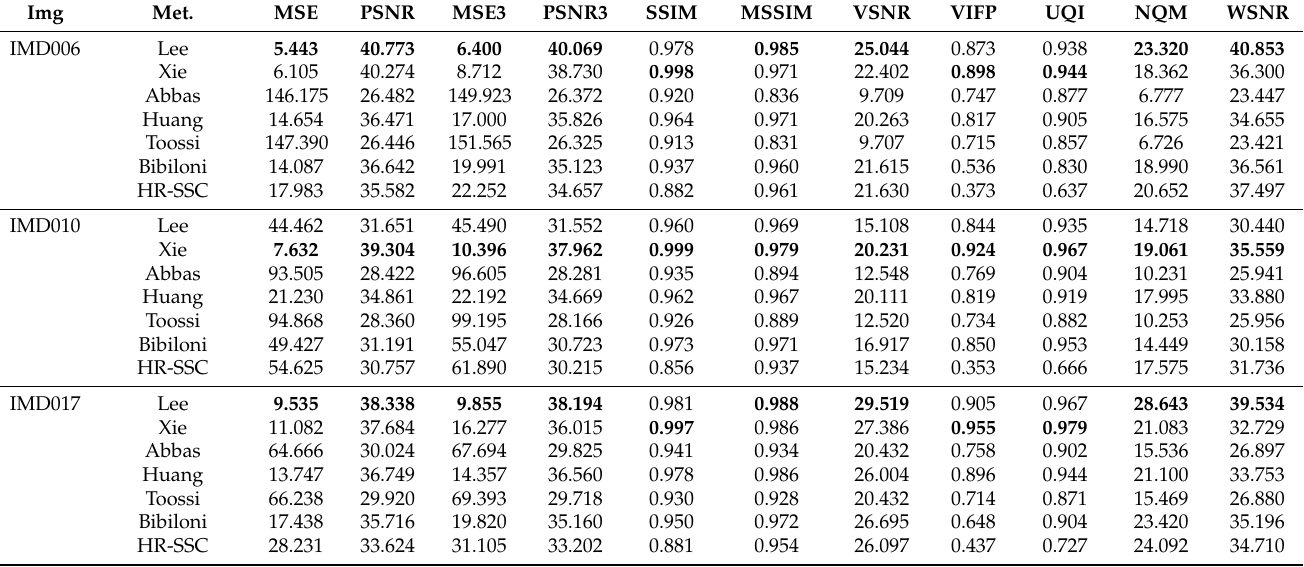
Table 2. Quality evaluation of the results on the H13Sim-data —best results are in bold. Img